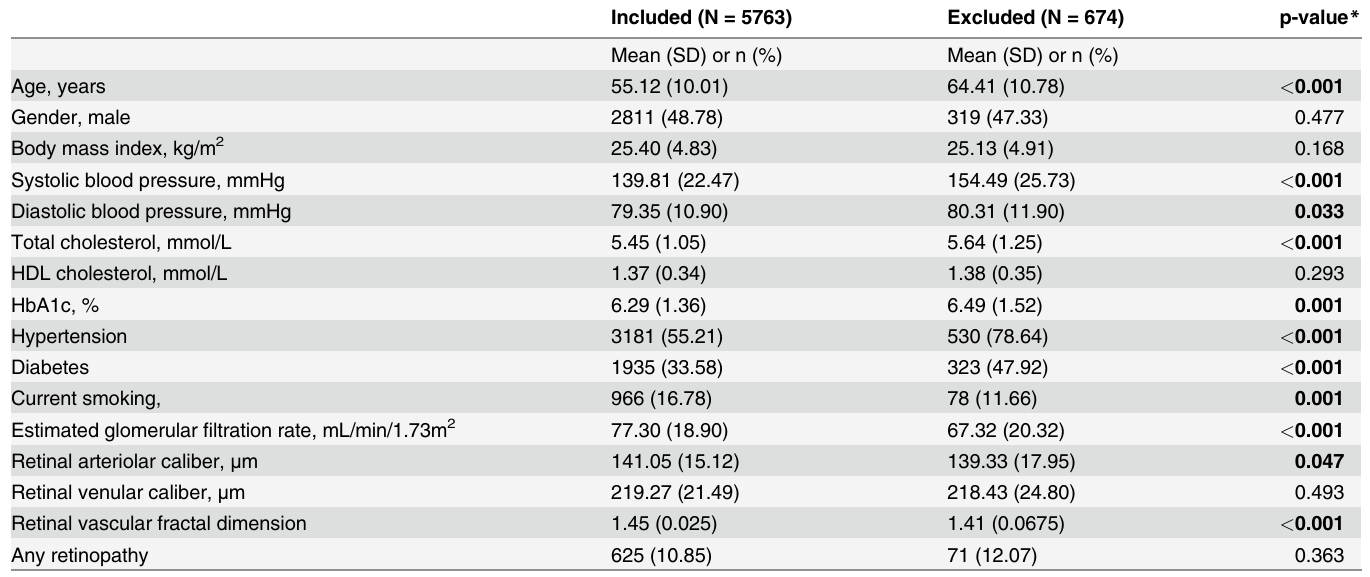
Table 1. Baseline characteristics comparing between those who were included to those who were excluded from the study.